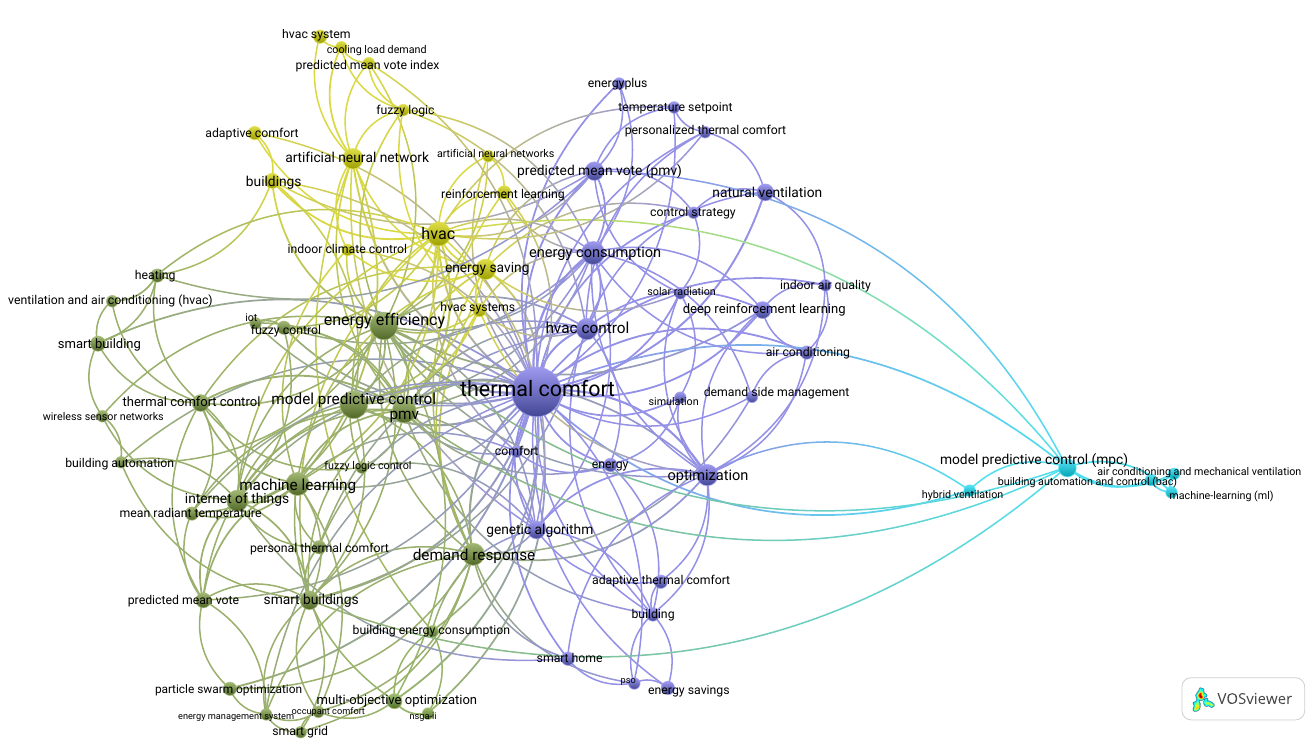
Figure 7. Keyword co-occurrence